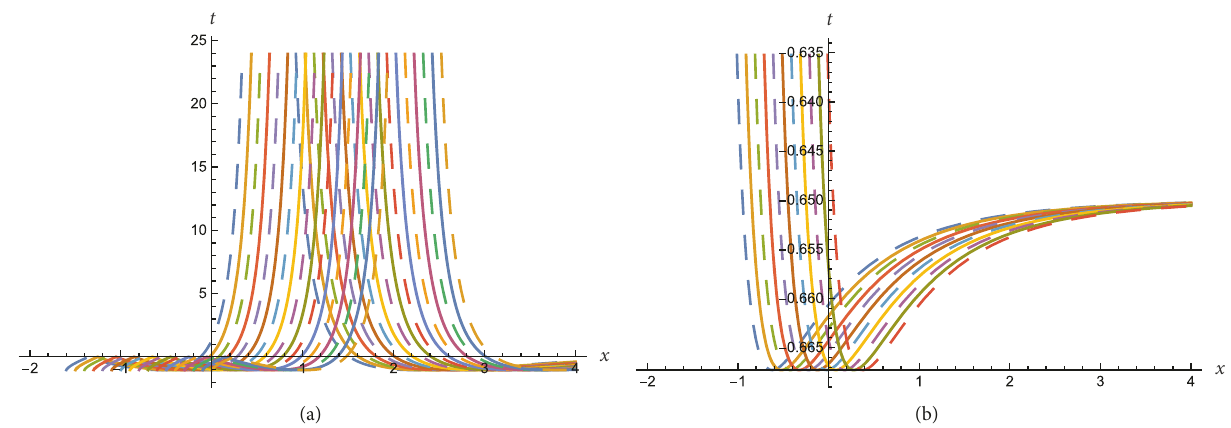
Figure 5: Plot of the exact traveling wave solutions of (a) bright solitary wave solution (31) with parameters 𝑎 1 = 1;𝛼 = 0.6; 𝑙 1 = 9;𝑙 2 = −10; 𝜅 = 0.7;𝑐 = 0.1;𝑦 = 0.8 ; (b) soliton solitary wave solution (33) plotted at 𝑎